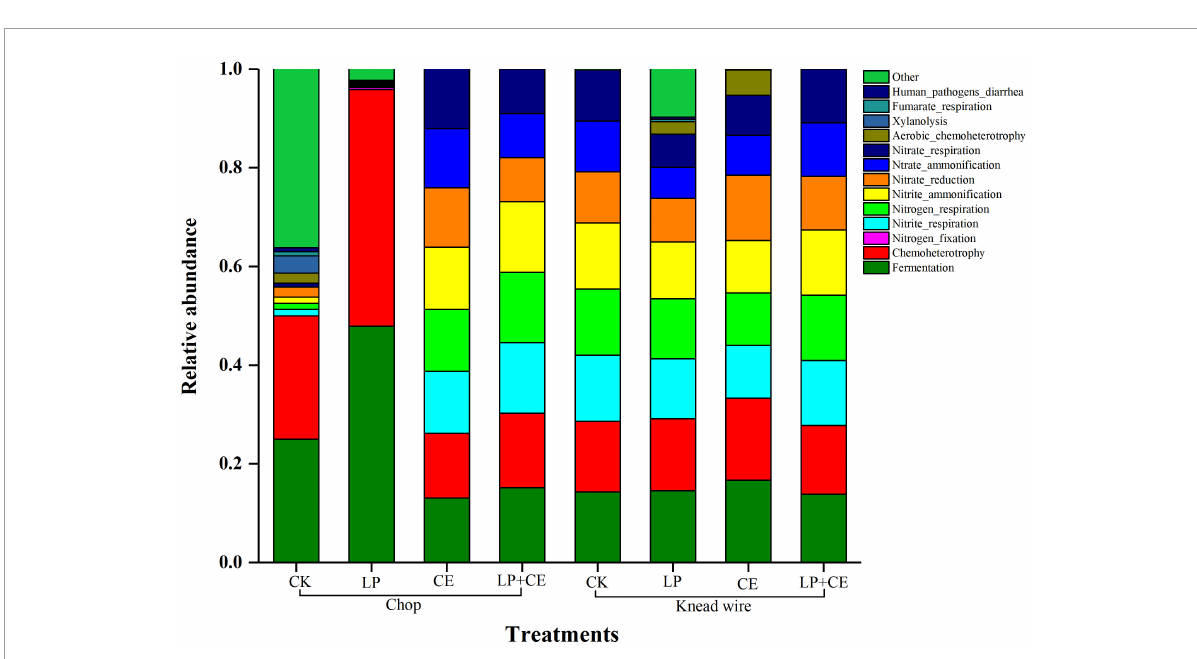
FIGURE3 Functional prediction of the bacterial community of 60-day Saccharum arundinaceum silage. CK, control; CE, cellulase; LP, Lactobacillus plantarum ; LP + CE, combination of L. plantarum and cellulase. CK, control; LP, L. plantarum ; CE, cellulase; LP + CE, L. plantarum plus